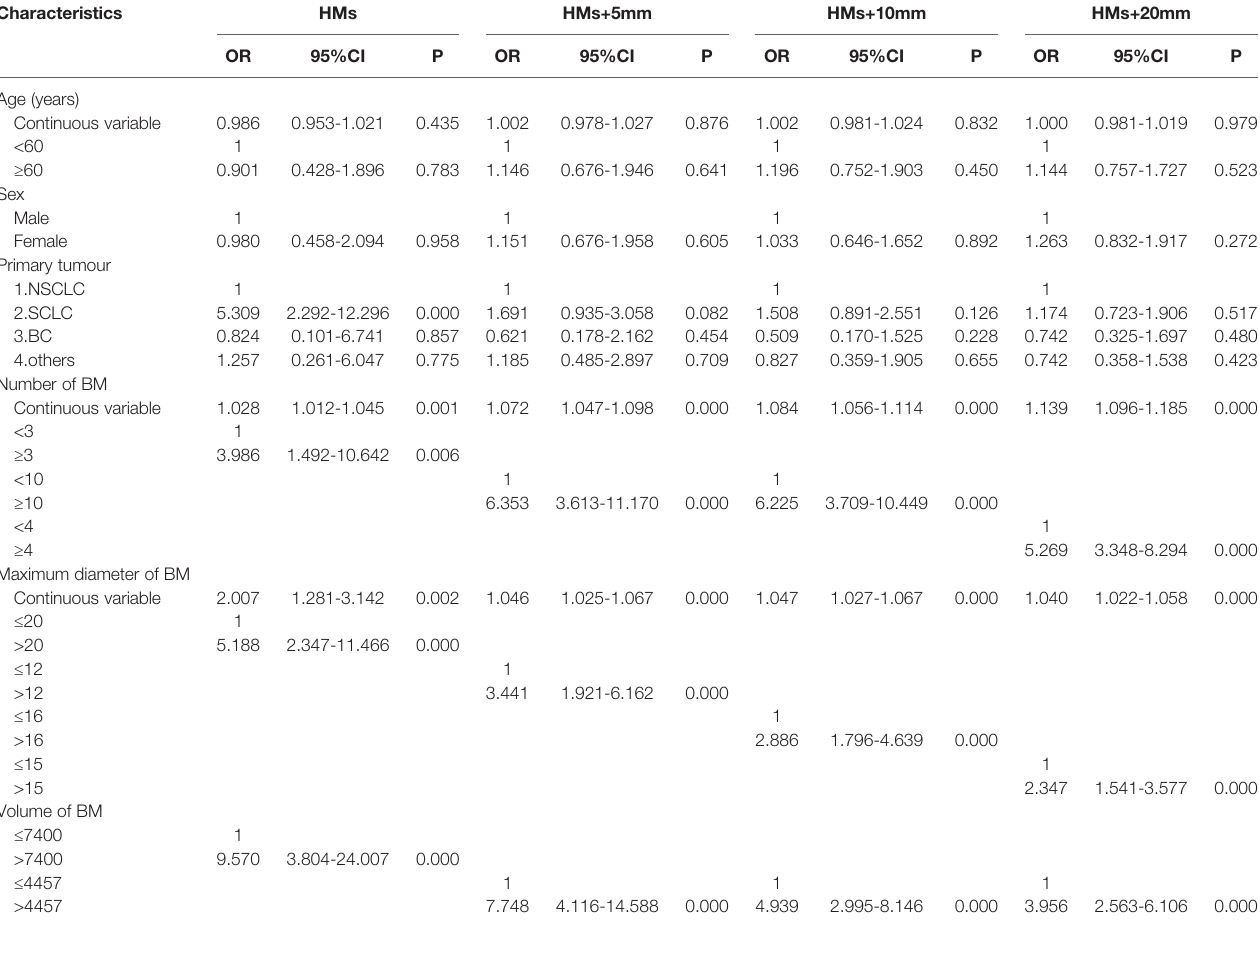
TABLE 4 | Univariate analysis of the risk factors of hippocampal involvement with different margin de fi nition. Characteristics